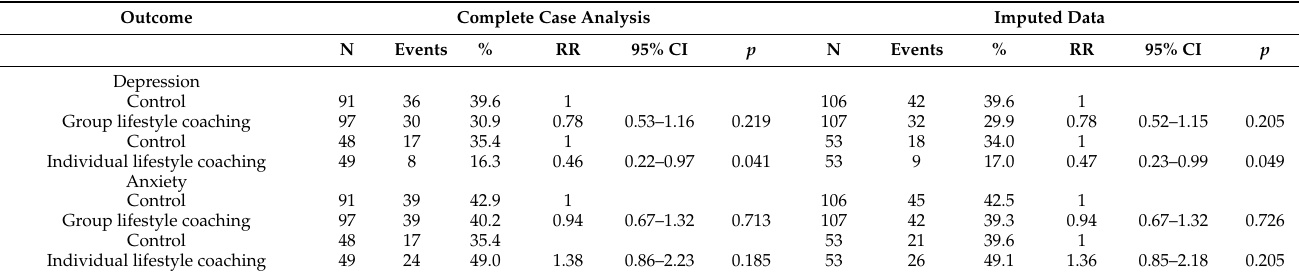
Table 2. The effects of group and individual lifestyle coaching on depression and anxiety (binary outcomes) based on complete case analysis and multiple imputed data. RR, risk ratio; %, proportion of outcome.